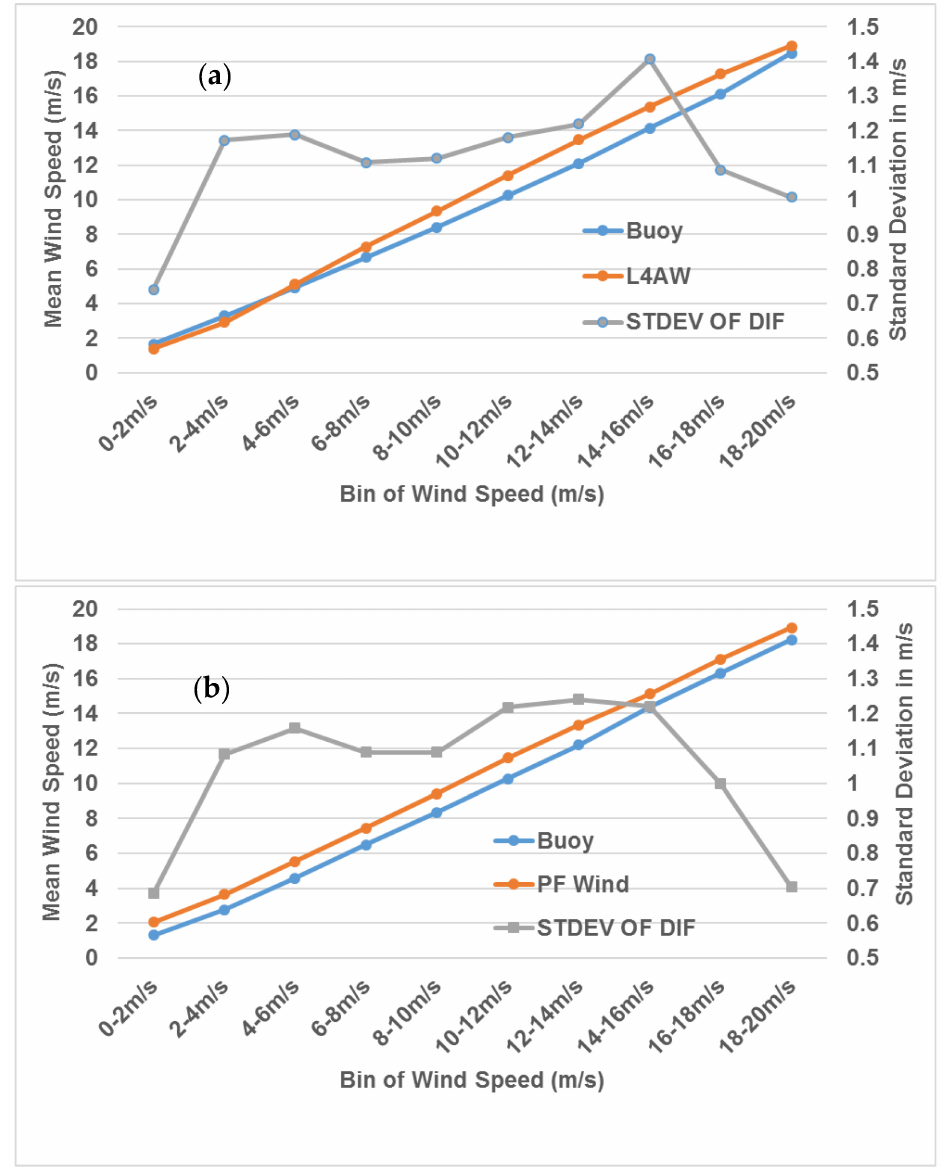
Figure 12. Mean wind and standard deviation of the difference between NDBC global buoy winds and ( a ) analyzed L4AW wind and ( b ) PF-wind for the year